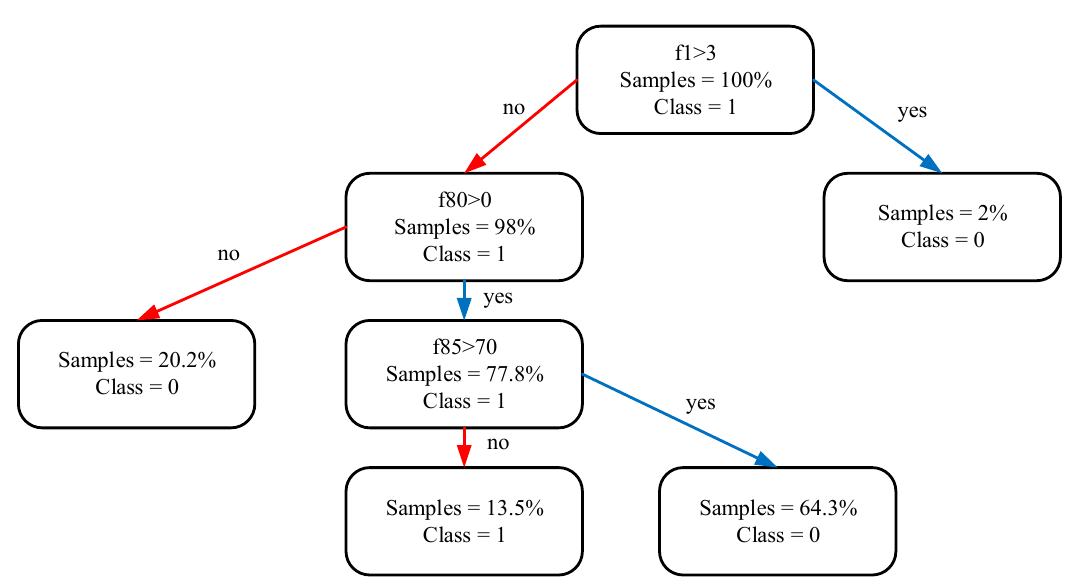
Figure 6. Feature importance for the Random Forest algorithm.